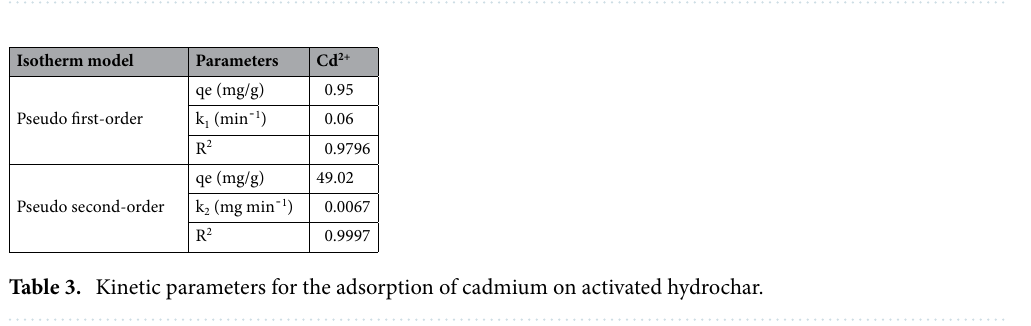
Figure 5. Separation factor against initial cadmium concentration and D–R isotherm model of cadmium ions.